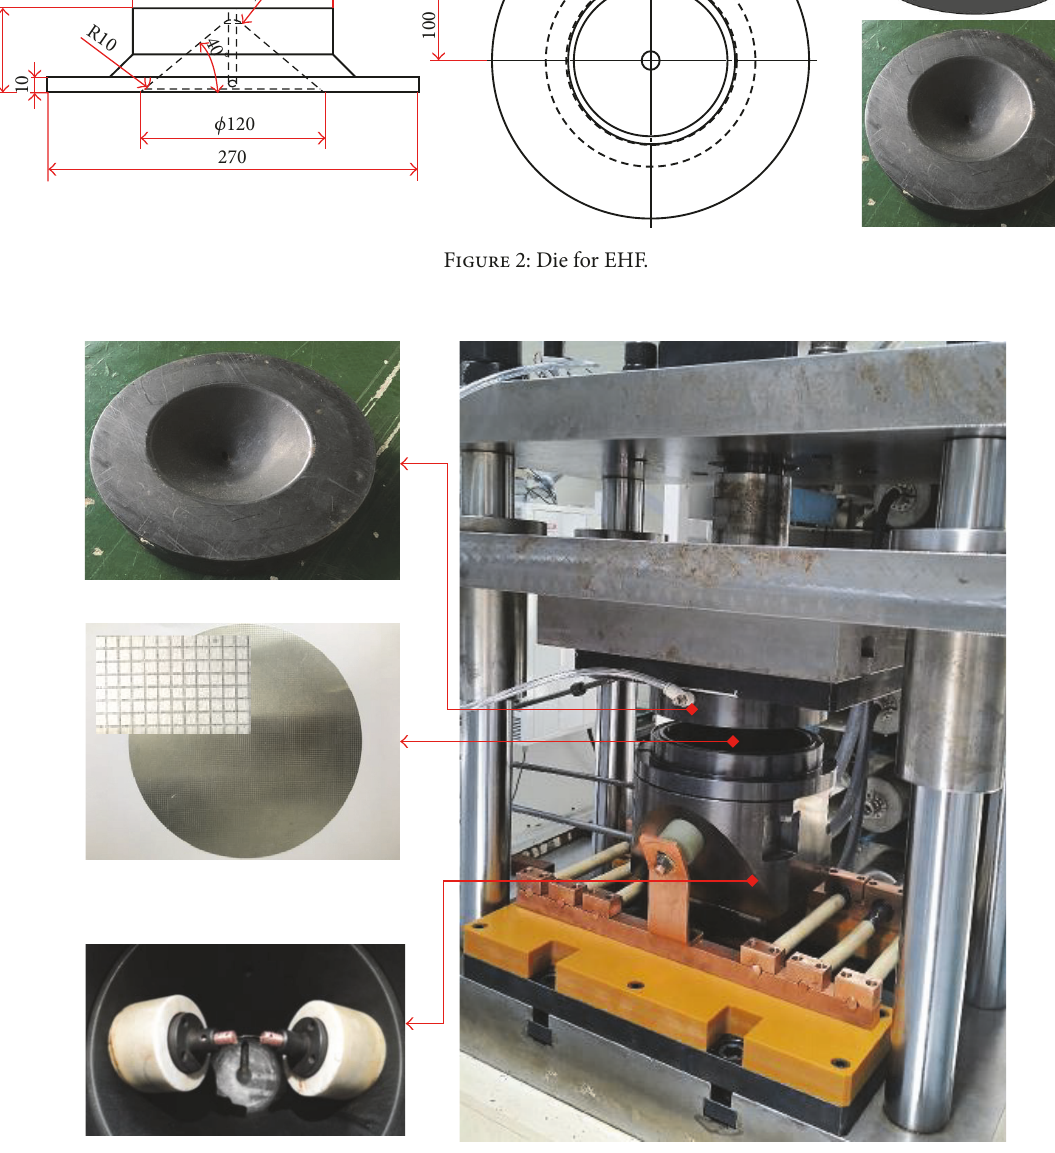
Figure 3: Set-up for